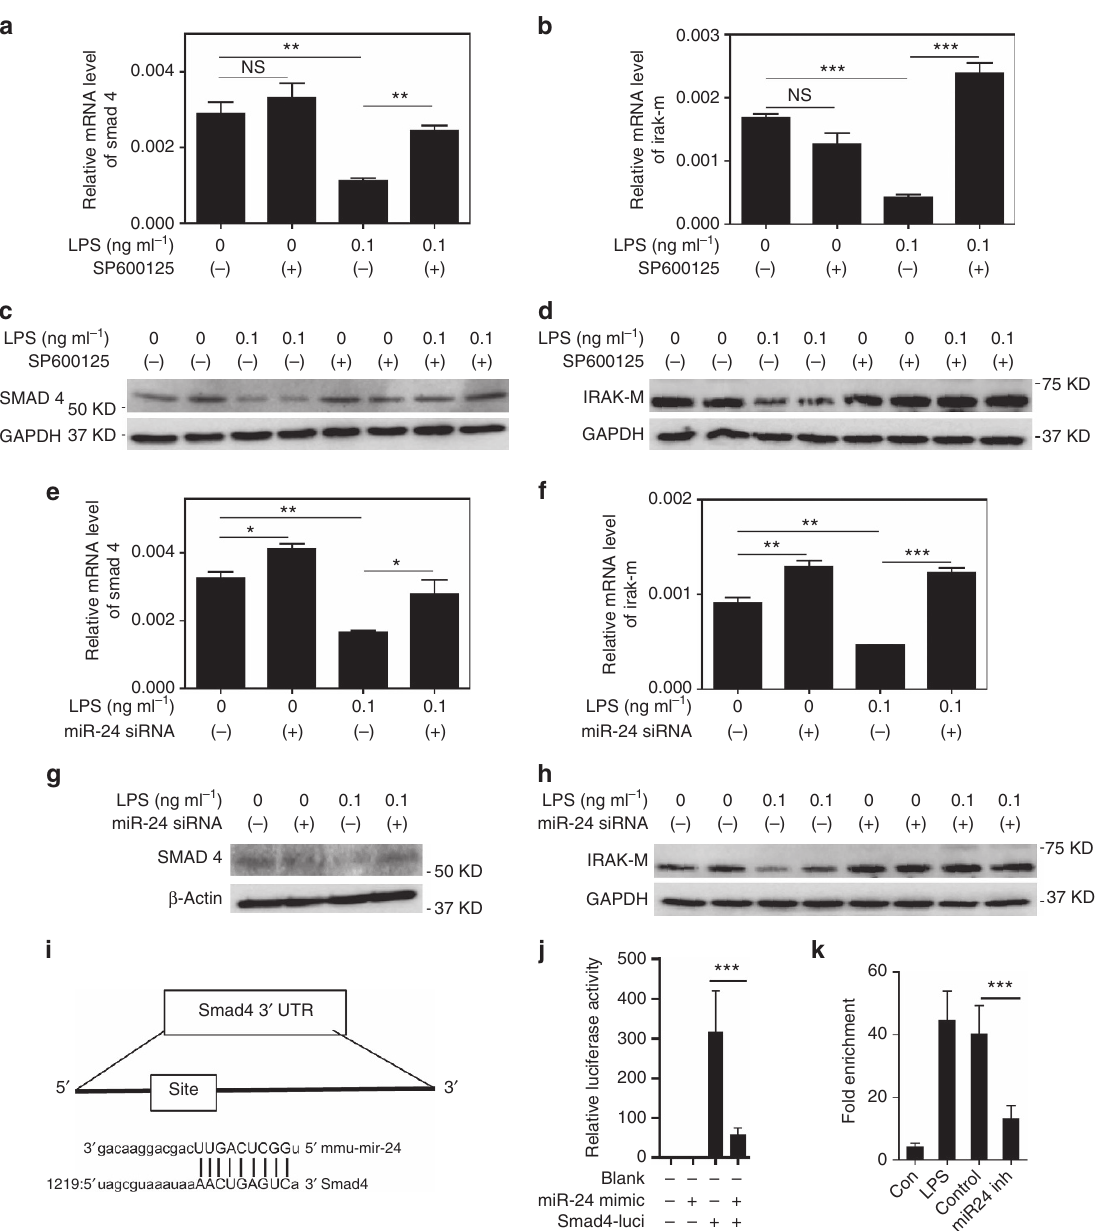
Figure 6 | The disruption of the IRAK-M homeostatic circuit is due to miR-24-mediated suppression of Smad4. ( a – h ) BMMs from C57 BL/6 mice were cultured with M-CSF (10ngml (cid:2) 1 ) in the presence of LPS (0.1ngml (cid:2) 1 ) for 5 days and SP600125 or miR-24 antagomir was added to indicated cultures. Fresh LPS, SP600125 and miR-24 antagomir was added every 2 days. The mRNA and protein levels of SMAD4 and IRAK-M in the cell cultures were analysed by real-time reversre transcriptase–PCR and western blotting, respectively. ( i ) A schematic illustration of the SMAD4 3 0 -UTR and potential miR-24 binding sites. ( j ) Luciferase activity assays in 293Tcells transfected with SMAD4 3 0 -UTR luciferase reporter plasmids in the presence of miR-24 mimic or the scramble control. ( k ) BMMs were cultured for 5 days and miR24 antagomir was transfected. On 7 days, the cells were stimulated by LPS (0.1ngml (cid:2) 1 ) for 4h and then harvested for RNA co-immunoprecipitation (RIP). Quantified data are shown from cells with indicated treatment ( n ¼ 3) and results are representative of three experiments. Error bars show means ± s.e.m.; NS, not significant; * P o 0.05, ** P o 0.01 and *** P o 0.001; one-way analysis of